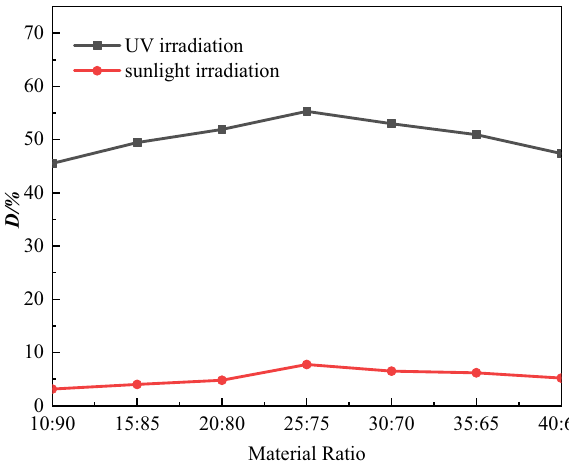
Figure 1: Photocatalytic degradation e ffi ciency of CdS/TiO 2 com - posite photocatalysts with di ff erent material ratios.